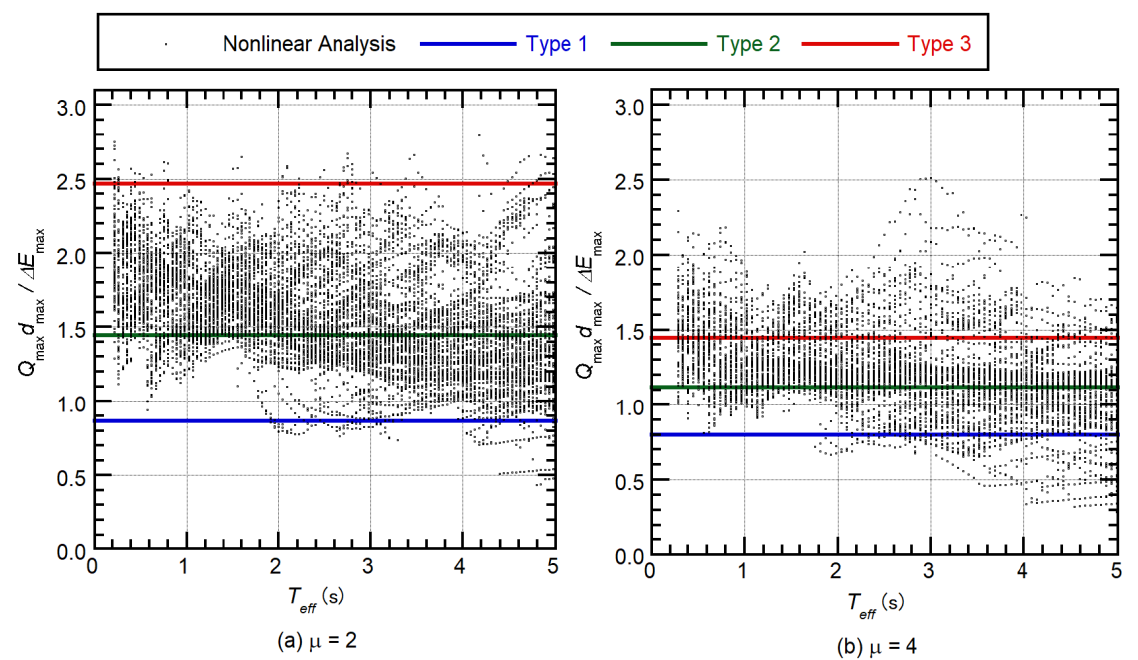
Figure 12. Relationship between effective period T ef f and Q y d max / ∆ E max obtained from nonlinear analysis